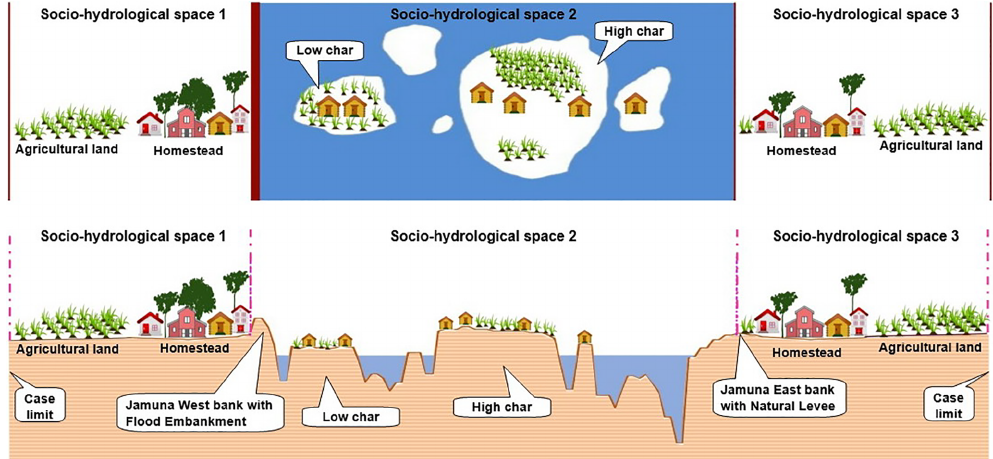
Figure 3. A typical planform and cross section with distinct SHSs along the